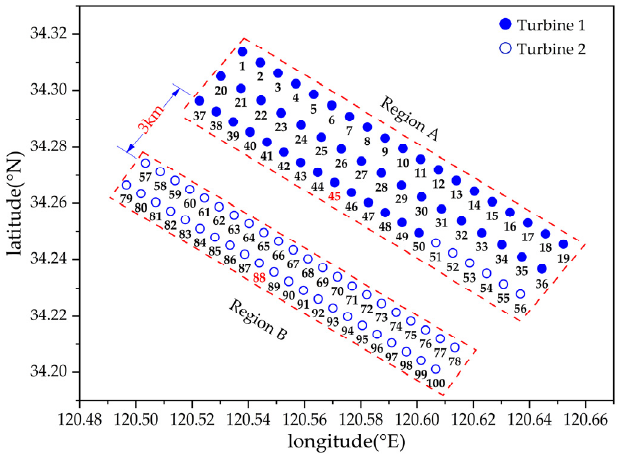
Figure 5. The wind turbine arrangement in the offshore wind farm and the division of region A and region B. Two different types of wind turbines are presented in solid and hollow dots, respectively. Red numbers mark the wind turbines selected to be analyzed in this research. Table 1. The parameters of two types of wind turbines used in the wind farm. Wind Turbine Parameters